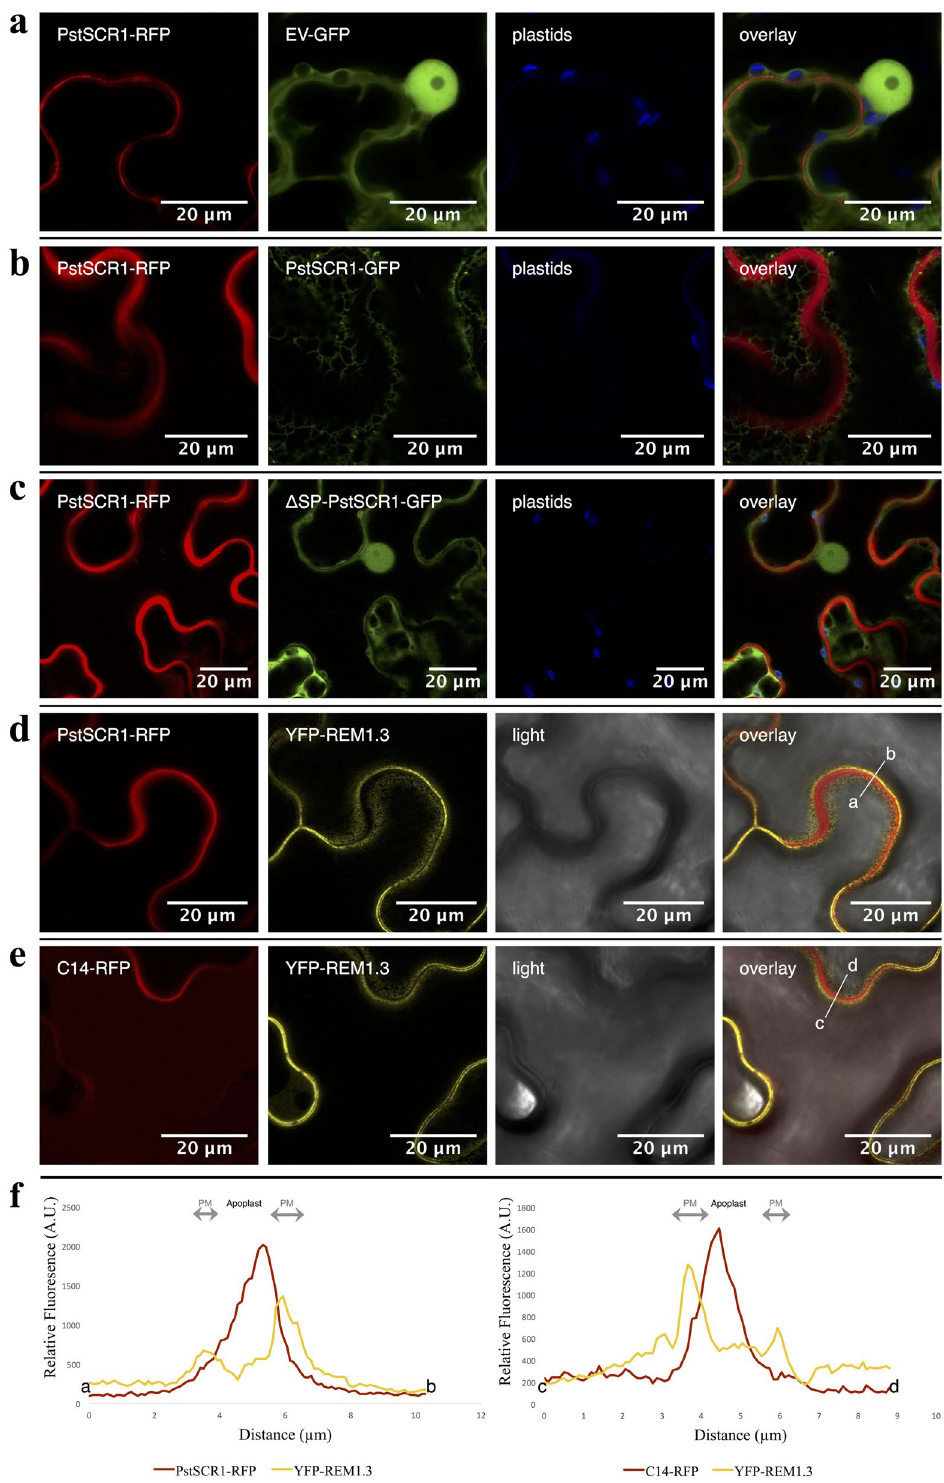
Figure 2. PstSCR1 accumulates in the plant apoplast. N . benthamiana plants were co-expressed by agro- infiltration using the following constructs: ( a ) pGWB454/PstSCR1-RFP and pK7FWG2/EV-GFP, (EV: empty vector), as nucleo-cytoplasmic marker; ( b ) pGWB454/PstSCR1-RFP and pK7FWG2/PstSCR1-GFP; ( c ) pGWB454/PstSCR1-RFP and pK7FWG2/ Δ SP-PstSCR1-GFP. ( d ) pGWB454/PstSCR1-RFP and pK7/YFP- REM1.3. ( e ) pGWB554/C14 (Apoplast and vacuole marker 47 ) and pK7WGY2/REM1.3 (Plasma membrane marker 58–60 ). ( d ) and ( e ) indicate PstSCR1 expressed with its SP accumulates in apoplastic space but not at the plasma membrane. ( f ) The intensity plots illustrate relative RFP and YFP fluorescence signals along the line connecting the points; a-b and c-d in overlayed images of ( d ) and ( e ),